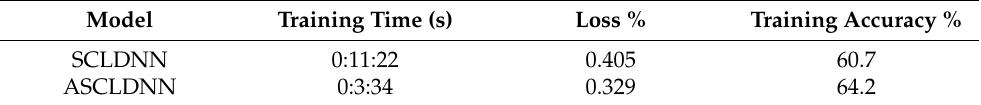
Table 1. Effects of adding attention mechanism on the model.